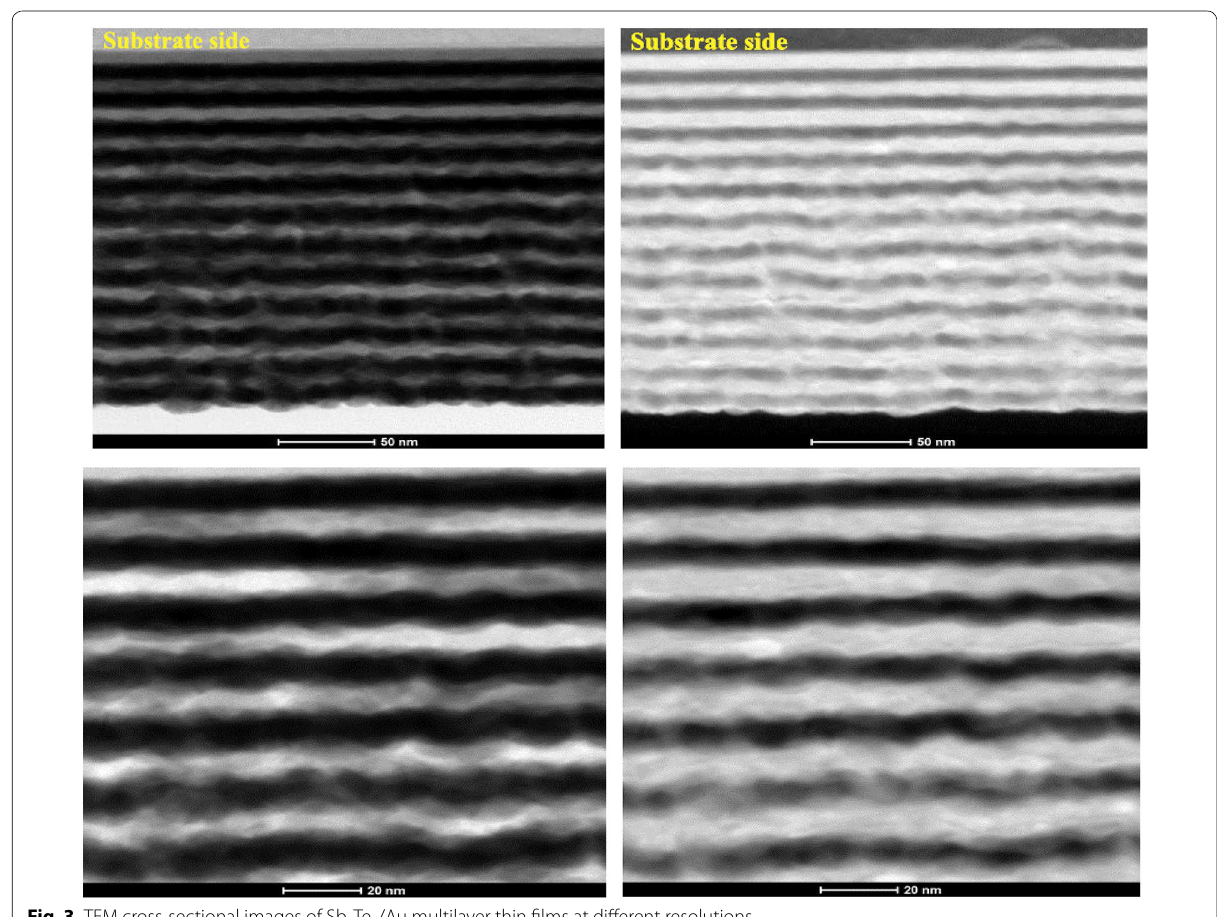
Fig. 3 TEM cross‑sectional images of Sb 2 Te 3 /Au multilayer thin films at different resolutions